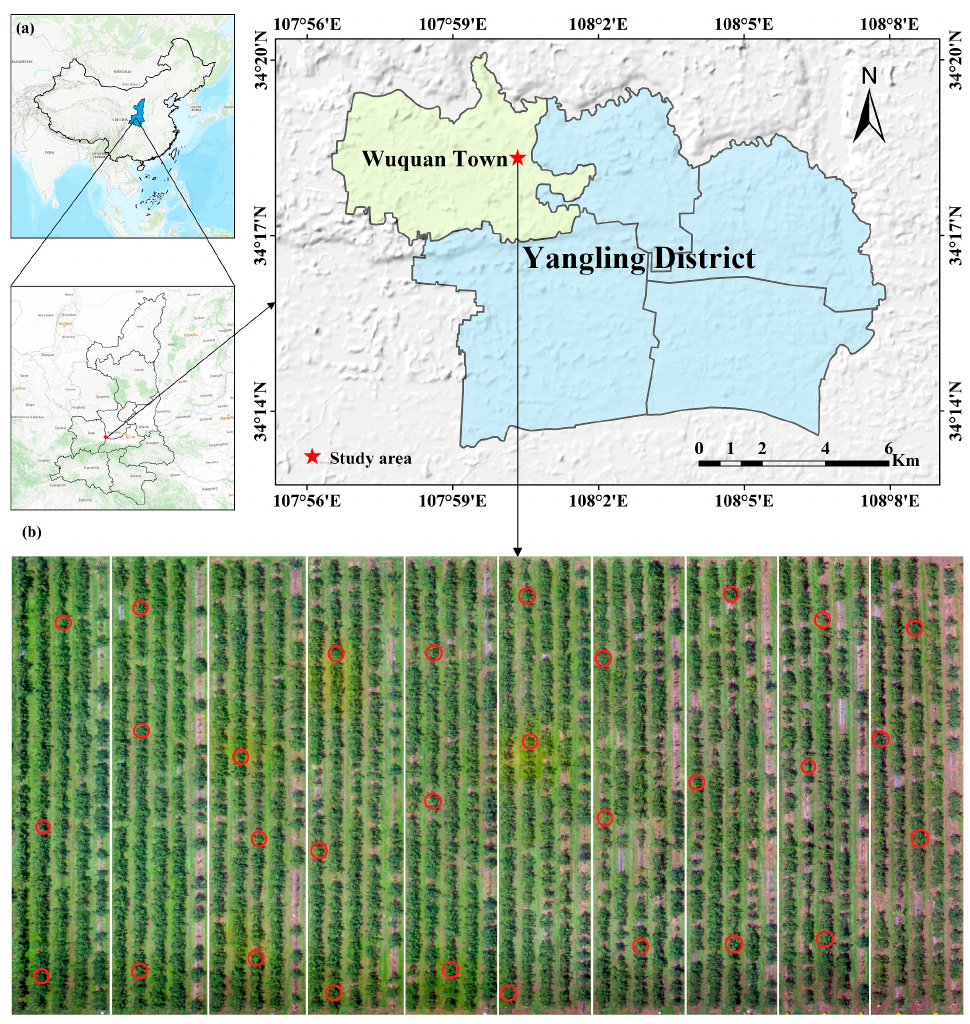
Figure 1. ( a ) Study area. ( b ) Location of sampled trees. Table 1. Degree of leaf disease and measurement area.